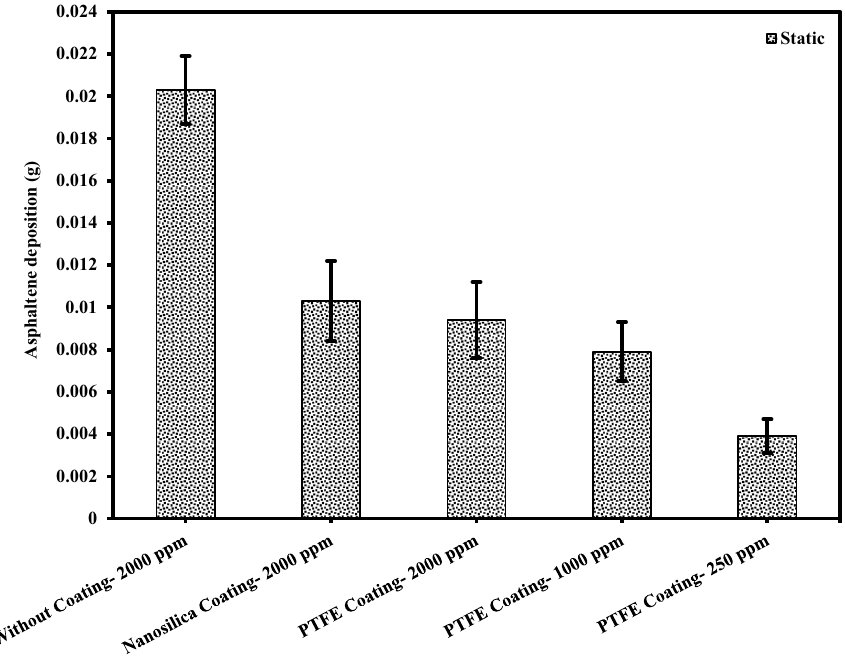
Figure 7. Comparison of coated and uncoated electrodes based on the amount of deposition at different asphaltene concentrations in static state at ambient pressure and temperature (The amount of asphaltene deposition were reported at the end of 300 s period).